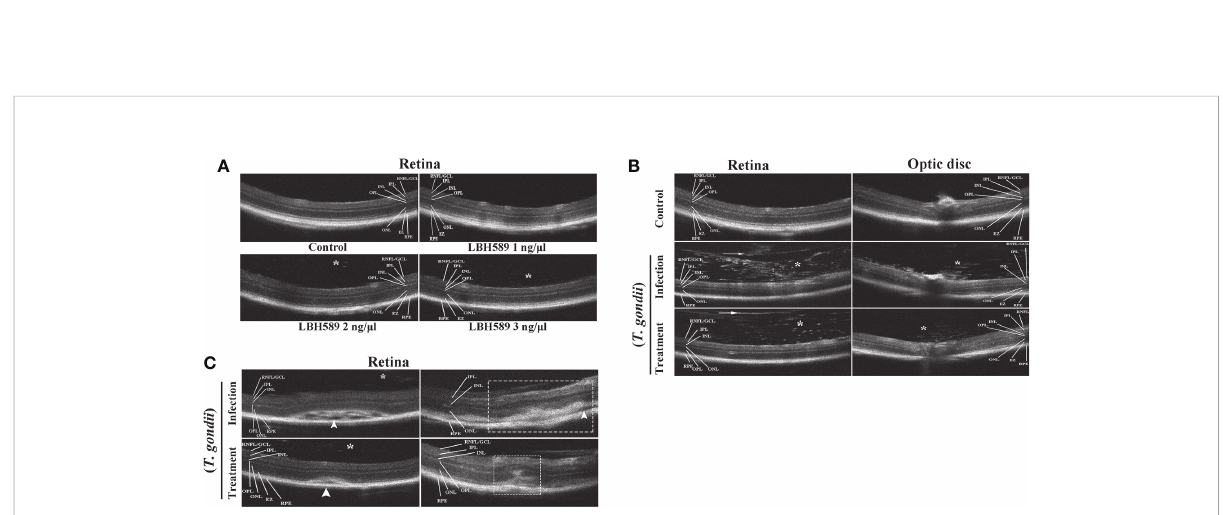
FIGURE 5 Clinical evaluation of vitreous cavity and retina structure after intravitreal injection of LBH589 by OCT. Normal mice were set as controls. (A) Scattered hyper-re fl ected signals (asterisk) are observed in the vitreous from intravitreal LBH589-injected ( ≥ 2 ng/1 m l) eyes. (B, C) Changes in the structure of retina and vitreous cavity of T. gondii -infected and LBH589-treated mice. The changes show dense hyper-re fl ective tiny dots (asterisk), posterior vitreous detachment (white arrow), serous retinal detachment (white arrowhead), blurred full thickness retinal, hyper-re fl ectivity foci and disorganized of retinal layers (white rectangle). Data are representative of results obtained from six mice in each